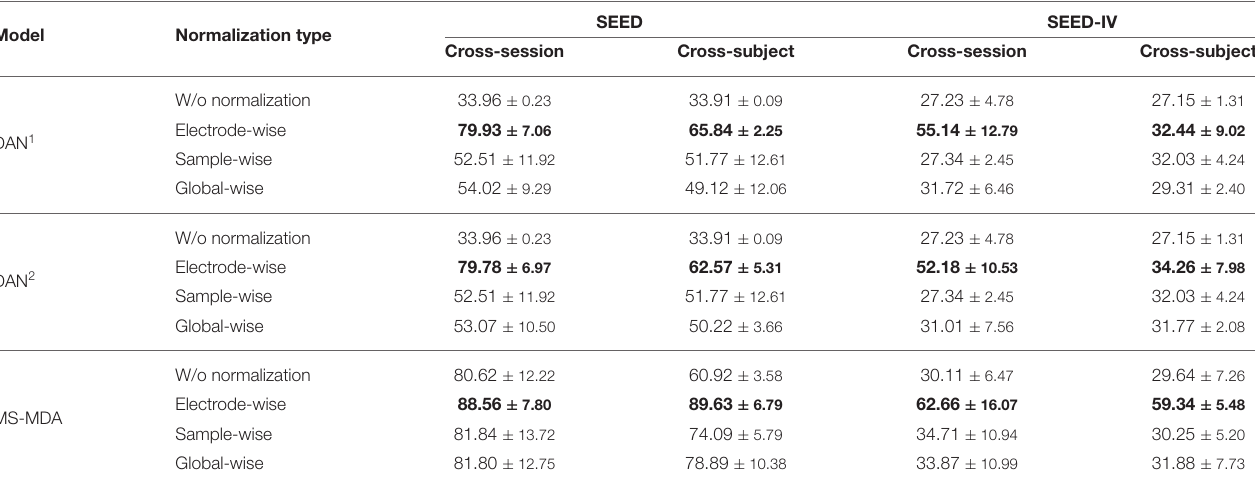
TABLE 4 | Normalization study of MS-MDA and DAN of